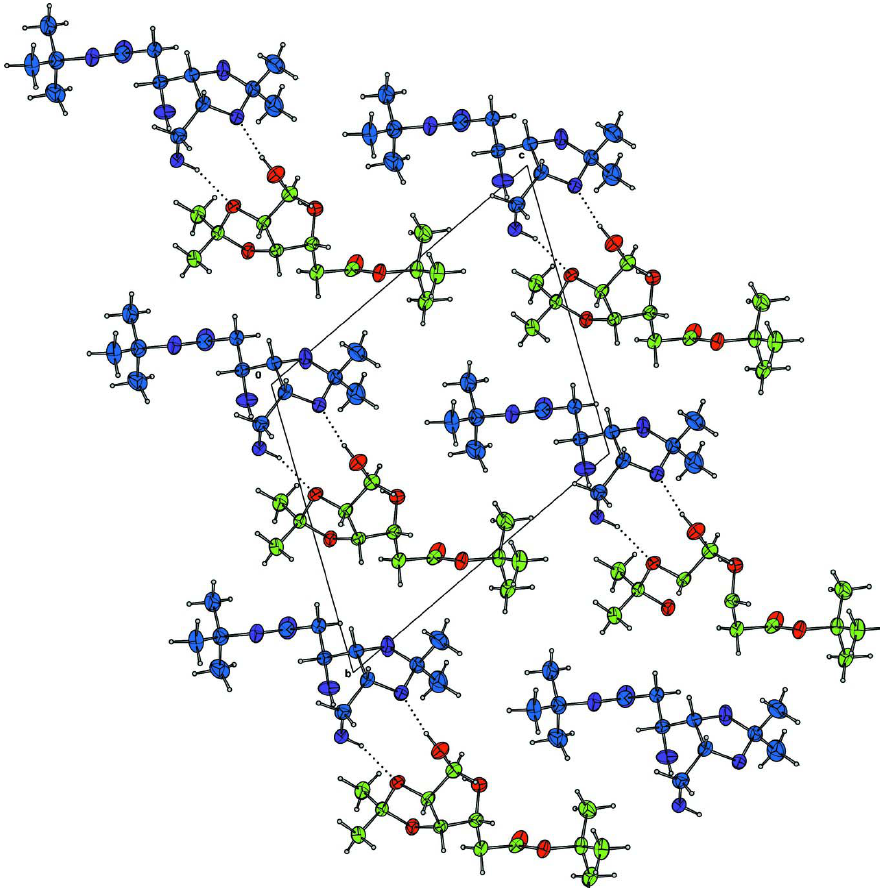
Figure 4 Packing diagram projected along the a -axis. Hydrogen bonds are shown by dotted